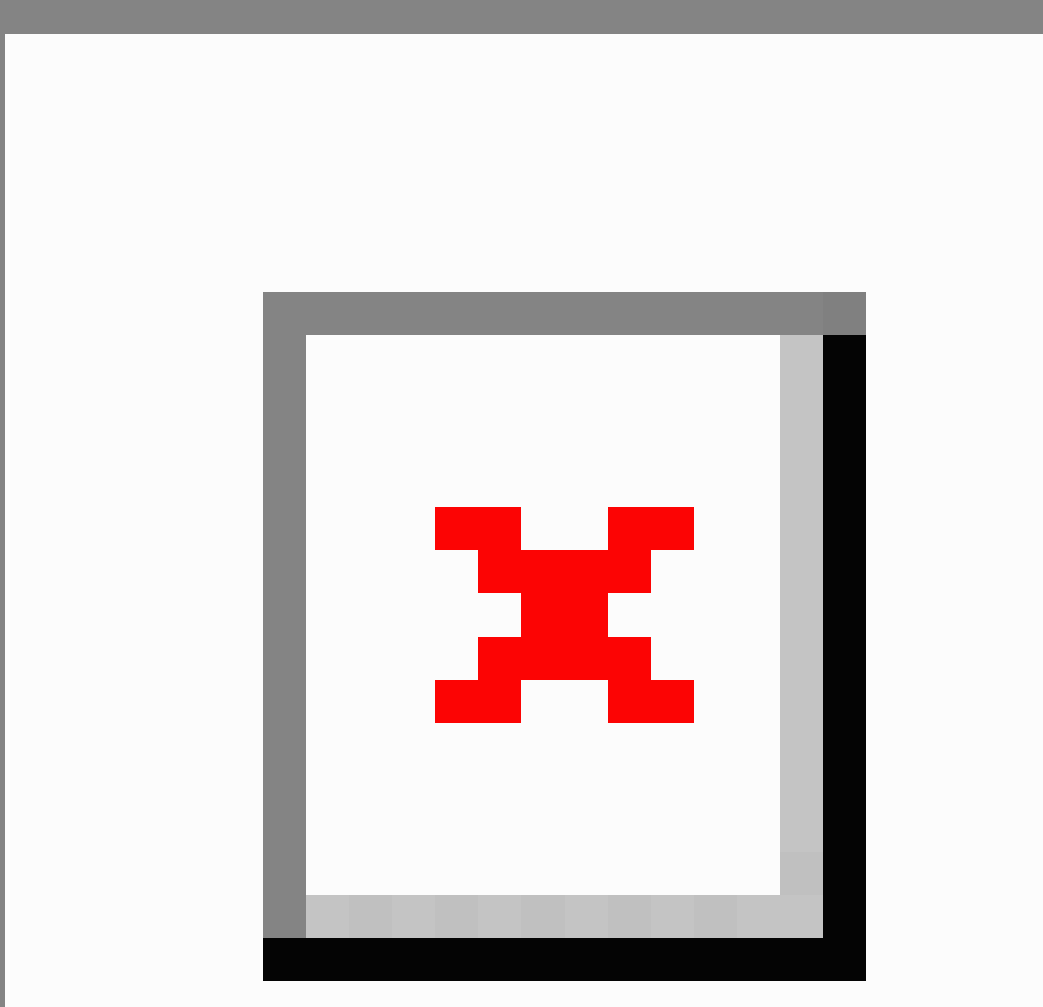
Figure 1. Facilitators of Fitbit use in young adolescents (n’s in brackets refer to the number of times a theme was mentioned during the focus groups). The dashed line indicates link made between different themes was noted by the researchers from the points discussed, rather than directly mentioned by the